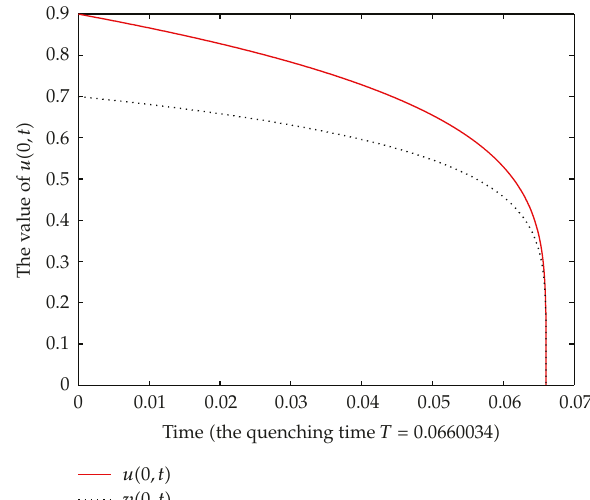
Figure 4: Evolution at the point x 0 (cid:3) 0 of the solution (cid:5) p 1 (cid:3) q 2 (cid:3) 1 , q 1 (cid:3) p 2 (cid:3) 3 (cid:6) .